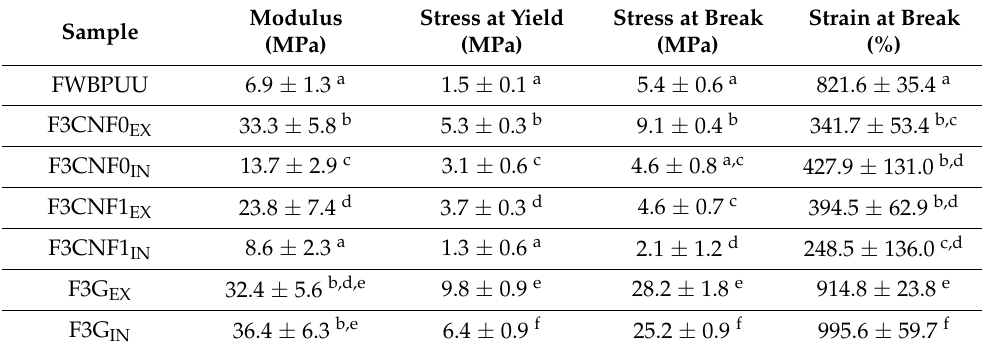
Table 2. Young modulus, stress at yield, stress at break and strain at break values for matrix and composites filaments. Values analyzed using one-way ANOVA with Tukey’s test, different letters indicate statistical differences, where values p < 0.05 were considered statistically